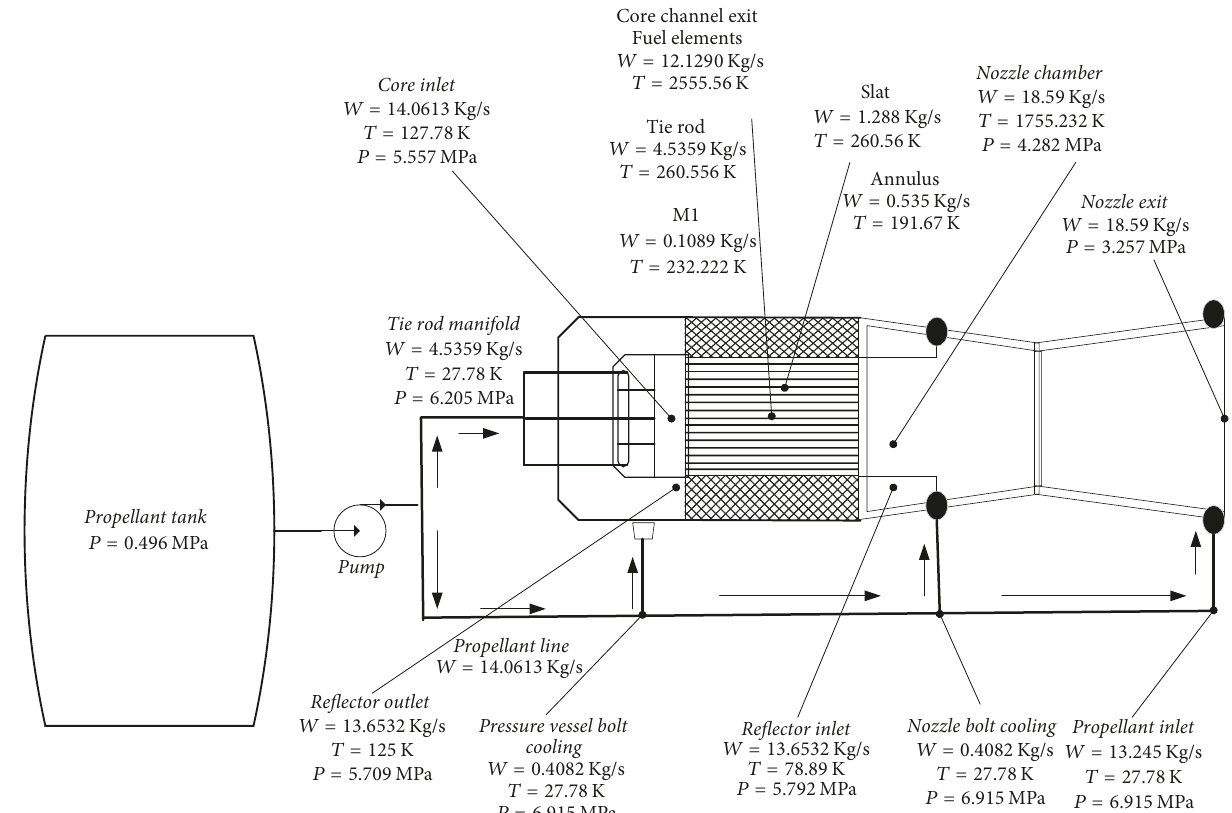
Figure 1: Pewee flow diagram (not drawn to scale).